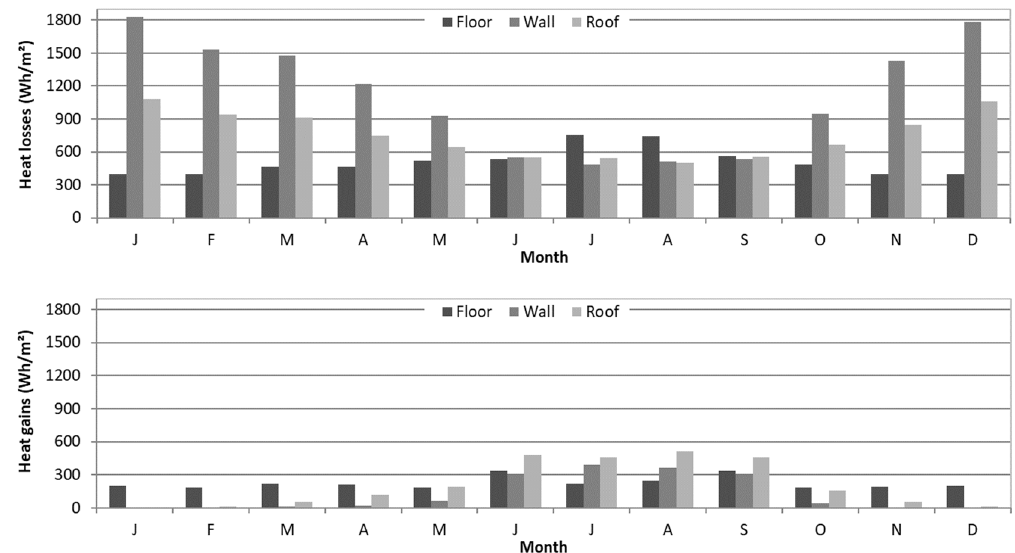
Figure 3. Energy losses-gains by conduction heat transfer (envelope) throughout the year in Soria.